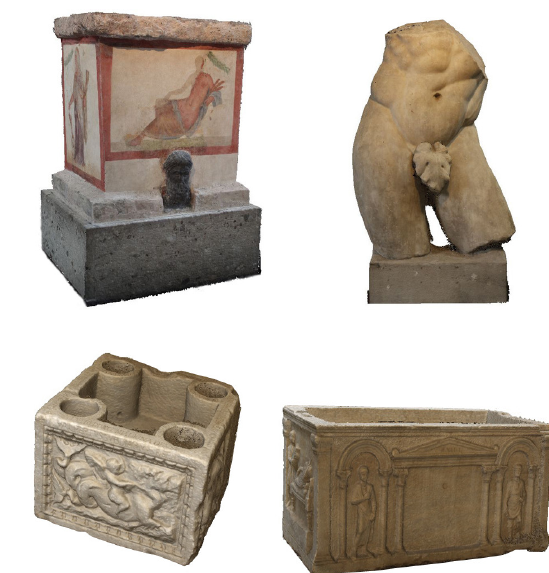
Figure 14 Four final models of different items stored in the Museum: an altar, a statue of Heracles, an angular piece of a public building, re-used several times, and a